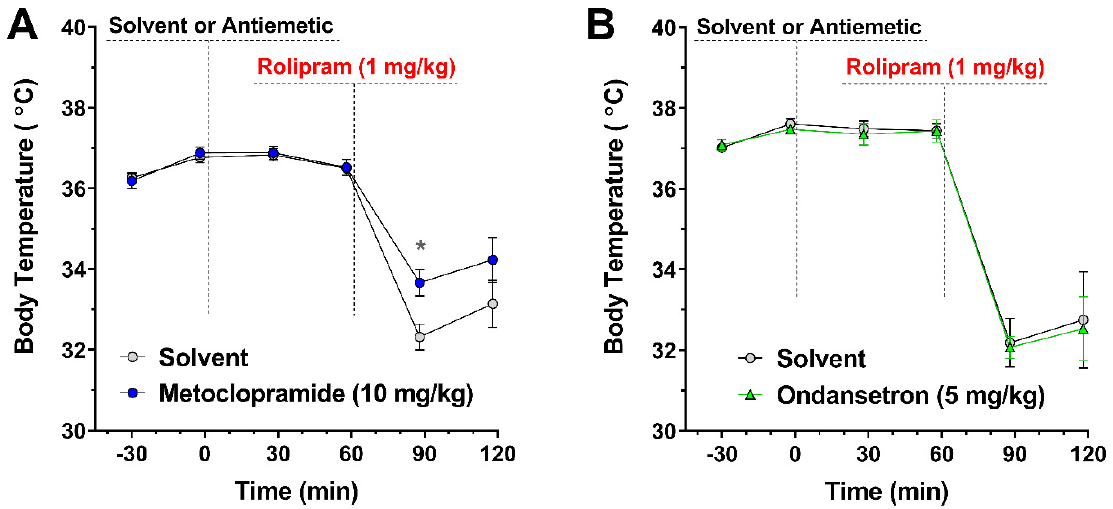
Figure 7. Effect of the antiemetics Metoclopramide and Ondansetron on PDE4 inhibitor ‐ induced hypothermia. After measurement of baseline body temperature (at − 30 and − 1 min), mice were treated with the antiemetics Metoclopramide (10 mg/kg; o.g.; n = 12) or Ondansetron (5 mg/kg; i.p.; n = 6) or their respective solvent controls (Solvent), followed 60 min later by injection of the PDE4 inhibitor Rolipram (1 mg/kg; i.p.). Body temperature was measured at the indicated time points using a rectal probe thermometer. Pre ‐ treatment with the prokinetic Metoclopramide ( A ), but not pre ‐ treatment with Ondansetron ( B ), alleviated PDE4 inhibitor ‐ induced hypothermia. All data represent the mean ± SEM. Statistical significance was determined using two ‐ way ANOVA with Sidak’s post hoc test and is indicated as * ( p < 0.05).